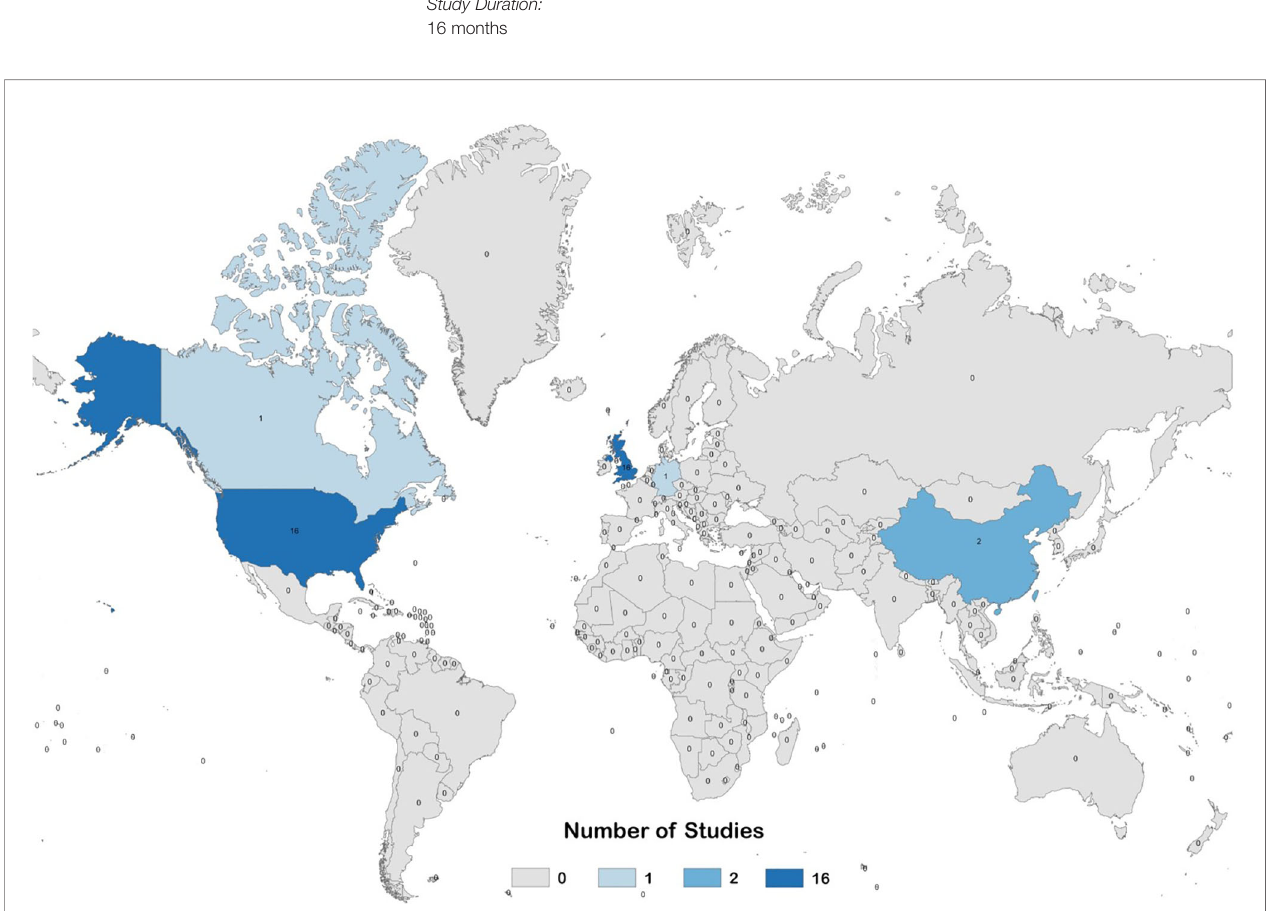
FIGURE 3 | Global heat map describing the number of pre-clinical studies evaluating prophylactic EBV vaccines per